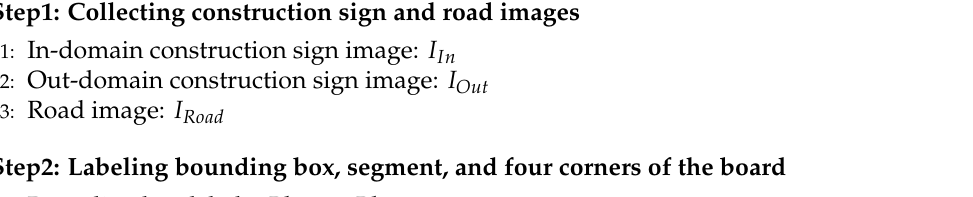
Algorithm 1 Pseudo-code of the proposed